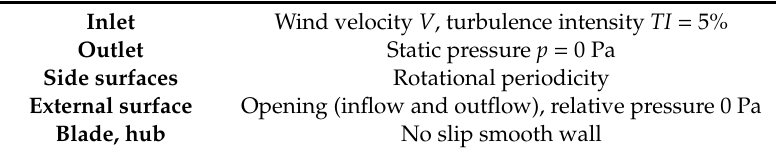
Table 2. Flow simulation boundary